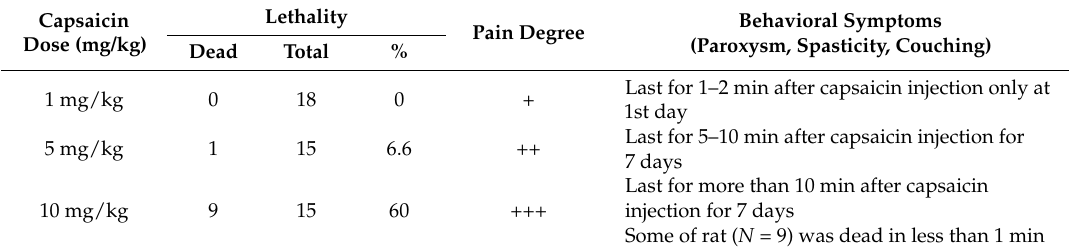
Table 2. Results of capsaicin dose effect test in lethality, pain degree and behavioral